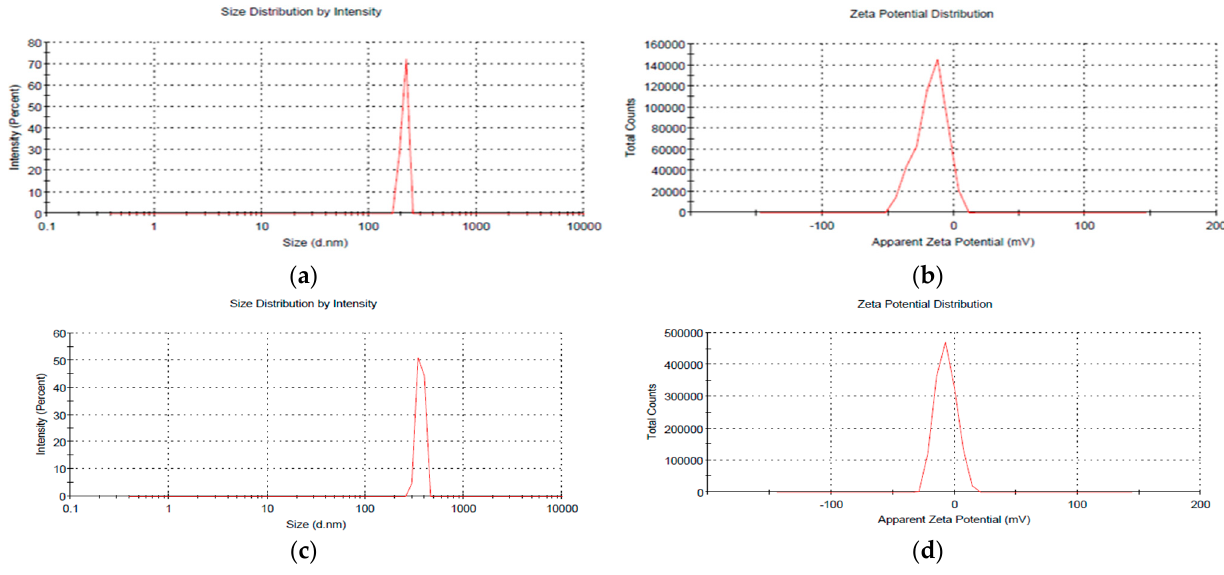
Figure 2. ( a ) Particle size and ( b ) zeta potential of CSGA blank NCs; ( c ) particle size and ( d ) zeta Table 1. Average size, PDI, and zeta potential of blank and loaded CSGA nanocomposites.